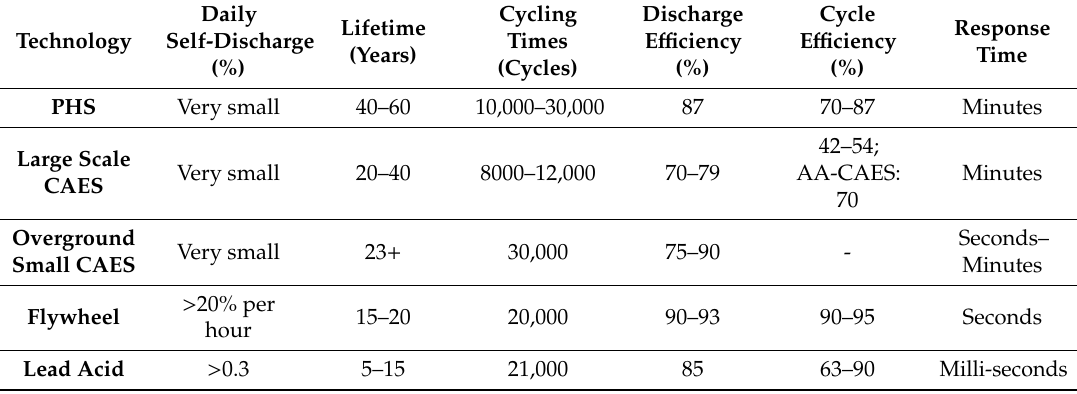
Table 15. Comparison of the technical parameters of di ff erent energy storage systems—II